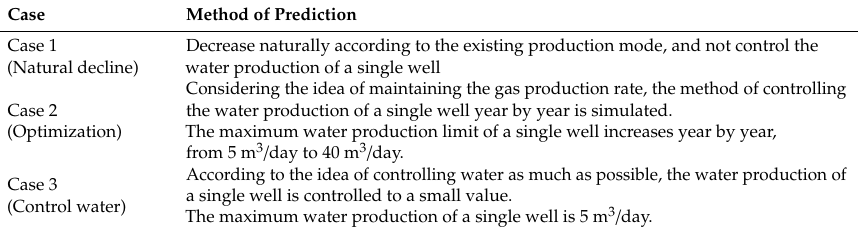
Table 3. Details of the cases of prediction for the field-scale five-well group model.